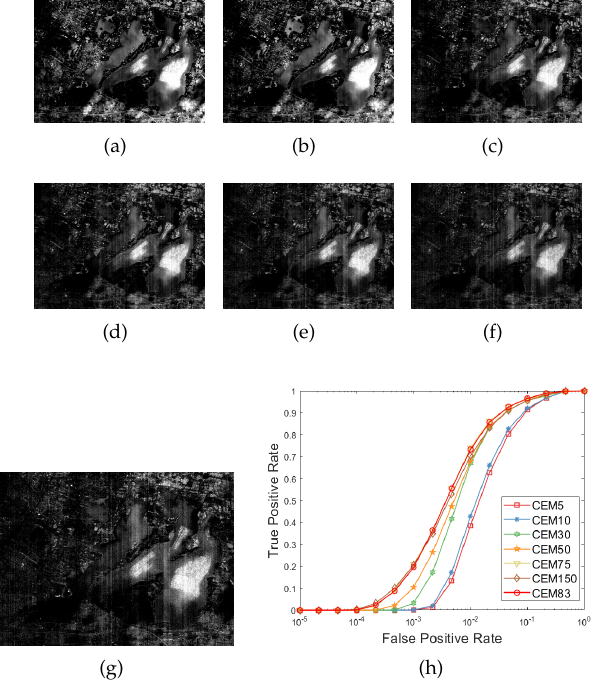
Figure 8. For the YC Lake data with 150 bands, ( a – f ): the CEM results for different L s ( L = 5, 10, 40, 50, 100, 150); ( g ): the CEM result with the skewness selection process, and L = 83; ( h ): the ROC curves with different L